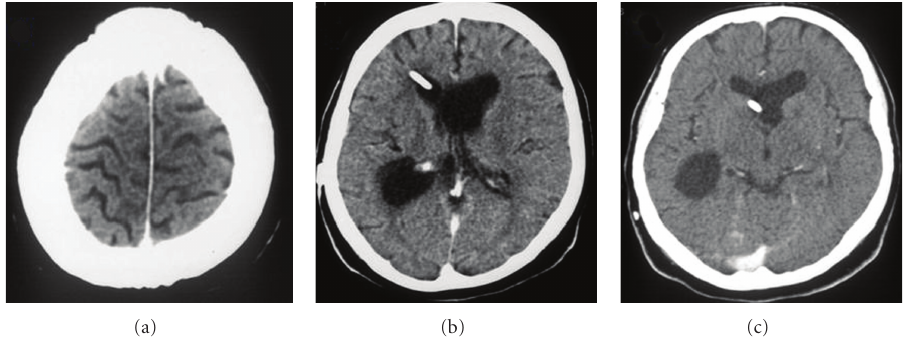
Figure 6: Noncontrast CT scans after endoscopic intraventricular cystic drainage and repositioning of the ventricular shunt